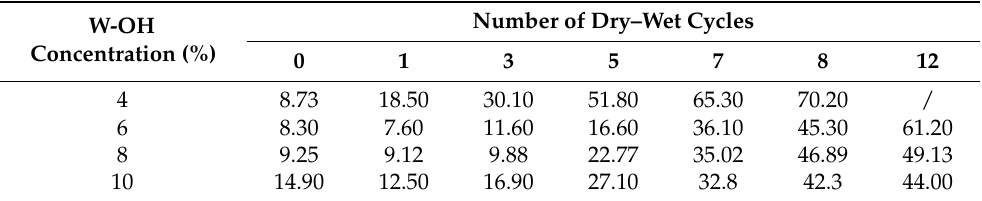
Table 5. Variations in dark spot rate with the number of dry–wet